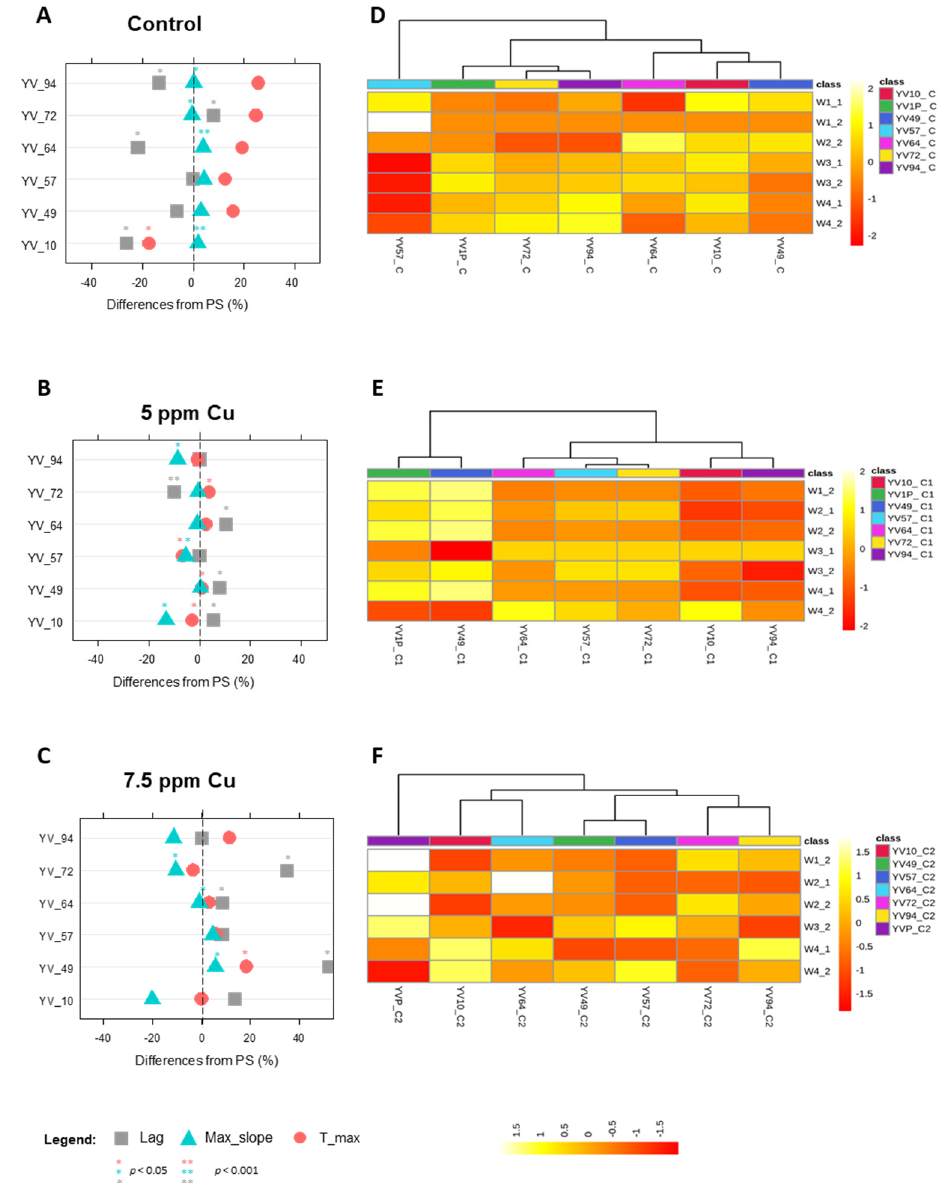
Figure 5. Growth and metabolomic phenotypes of YVGC13A S. cerevisiae parental strain and its derived MSCs during growth at increasing concentrations of copper (5–7.5 ppm). Panels ( A – C ): Lag time (grey square), max_slope (light blue triangle) and t_max (light red circle) parameters reported as percentage difference respect to the parental strain. Panels ( D – F ): Heatmap of the significantly altered FTIR peaks (distance measure using Euclidean, and clustering algorithm using ward.D). The coloured boxes indicate the relative intensities of the mean of peaks in the corresponding spectral region. The colour scale is log2 transformed value and indicates relatively high (yellow) and low (red) peak intensities. Spectral regions have been divided into sub-regions, namely: Fatty acids (W1_1 from 3200 to 3100 cm − 1 –W1_2 from 3098 to 2801 cm − 1 ); Amides (W2_1 from 1800 to1649 cm − 1 –W2_2 from 1647 to 1501 cm − 1 ); Mixed region (W3_1 from 1499 to 1352 cm − 1 –W3_2 from 1350 to 1202 cm − 1 ); Carbohydrates (W4_1 from 1200 to 1053 cm − 1 –W4_2 from 1051 to 902 cm − 1 ).